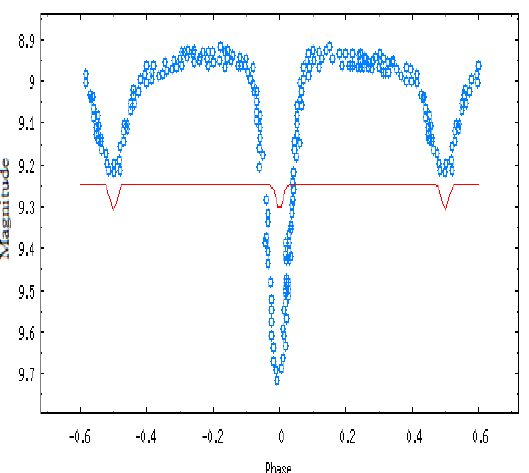
Fig.3: Synthetic and plotted light curves of eclipsing binary RT